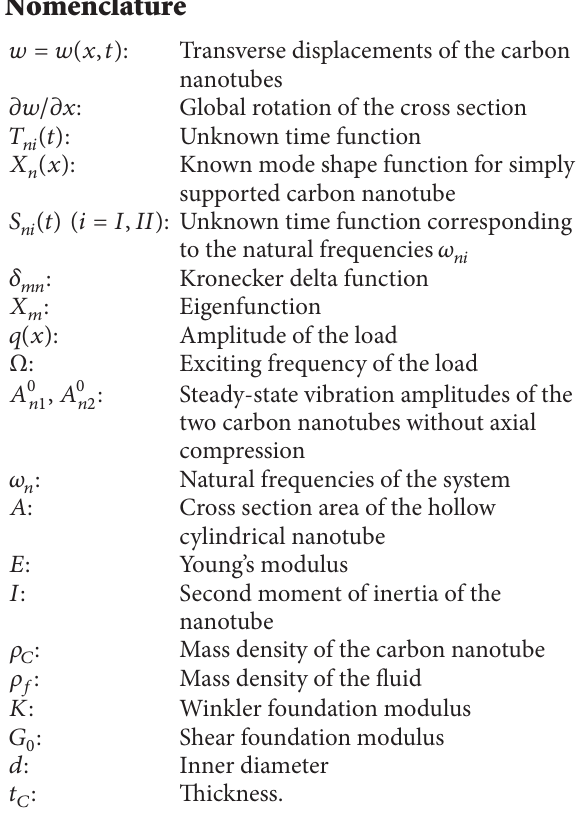
the magnitudes of the steady-state vibration amplitudes 𝐴 𝑛1 and 𝐴 𝑛2 get smaller when the vibration mode number 𝑛 becomes larger. The ratio 𝜑 1 decreases with the increase of the axial compression, which implies that the magnitude of the steady-state vibration amplitude 𝐴 𝑛1 becomes smaller when the axial compression increases, and the ratio 𝜑 2 increases with the increase of the axial compression, which implies